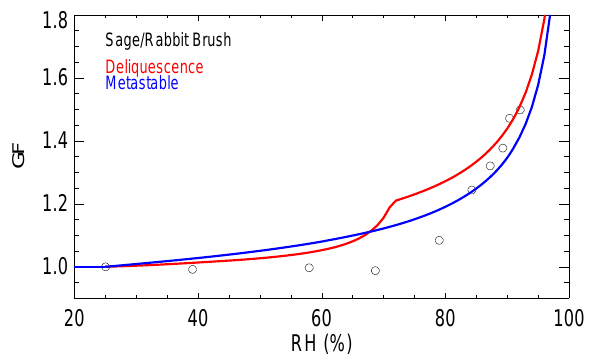
Fig. 3. Growth factors (GF) for 100nm smoke particles emitted Figure 3. Growth factors ( GF ) for 100 nm smoke particles emitted from Utah sage/rabbit from Utah sage/rabbit brush burns as a function of relative humidity brush burns as a function of relative humidity (RH, %). The GF results derived from the (RH, %). The GF results derived from the E-AIM model are for E-AIM model are for deliquescence and metastable equilibrium. deliquescence and metastable equilibrium.